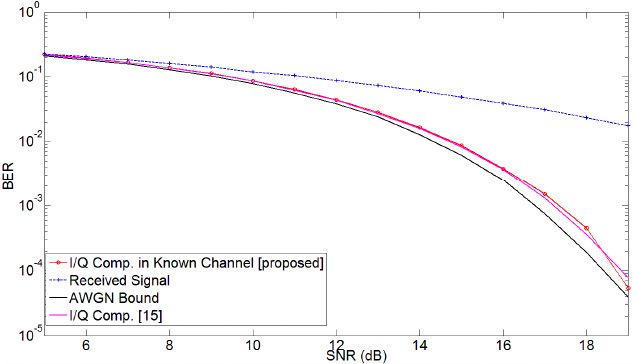
Figure 8. Bit error rate (BER) vs. SNR for the proposed model for 16 QAM orthogonal frequency division multiplexing (OFDM) signal with 1024 subcarriers for g = g ’ = 0.92 dB and θ = θ ’ = − 6 degrees.